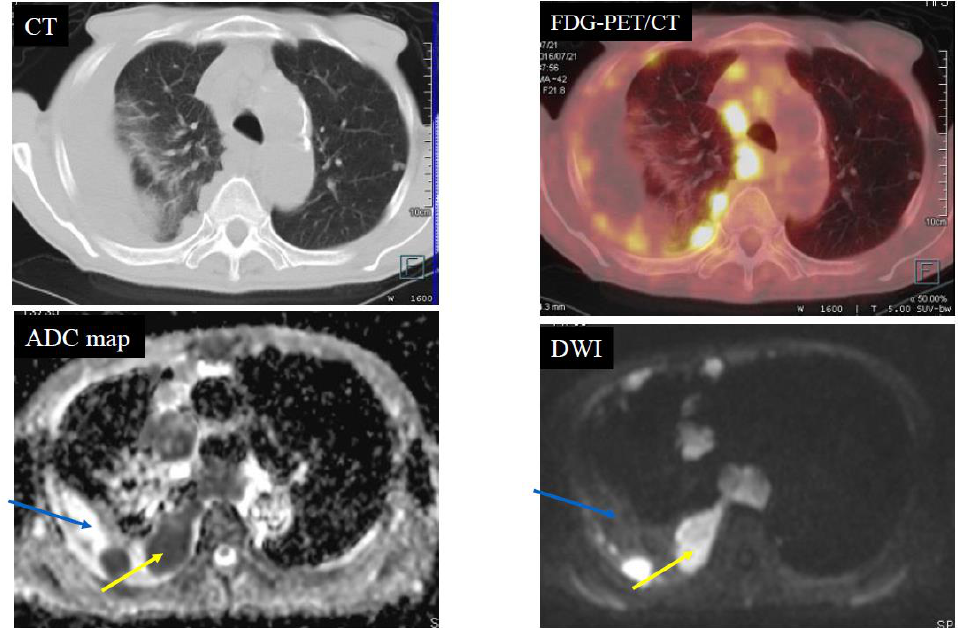
Figure 2. Case 2 — Pleural dissemination of lung cancer. An 81-year-old male with pleural dissemination of a large cell neuroendocrine carcinoma. The yellow arrows indicate pleural dissemination. The blue arrows indicate pleural fluid. The apparent diffusion coefficient (ADC) of the pleural dissemination was 0.67 × 10 -3 mm 2 /s (positive) and the ADC of the pleural fluid was 3.03 × 10 -3 mm 2 /s (negative). Fluorodeoxyglucose-position emission tomography/computed tomography (FDG-PET/CT) showed scattered accumulation (standardized uptake value (SUVmax): 14.7) of the FDG on the pleural dissemination.